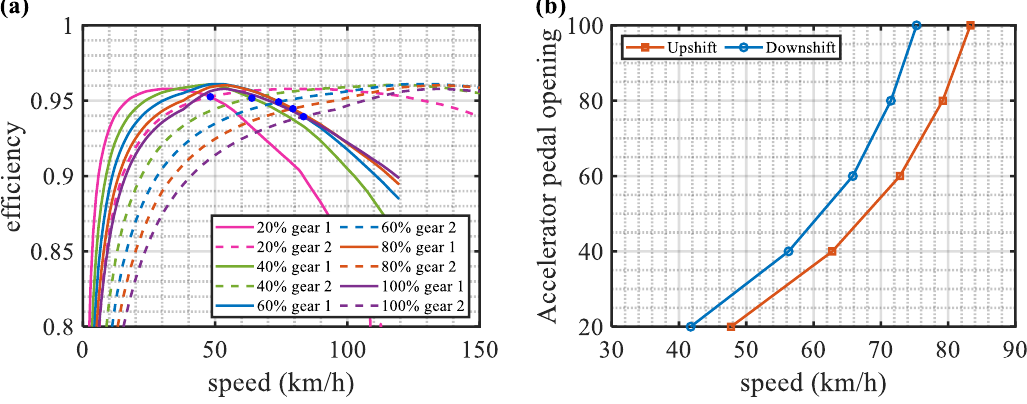
Figure 6. Economic shifting strategy: ( a ) motor efficiency curves; ( b ) economic shift curves. The economic shifting curve obtained by the above method is the upshift curve. The downshift curve is usually chosen to be another curve when the shifting speed is lower than the upshift curve. In this paper, a divergent shift rule was used to determine the economic downshift curve. This meant that the magnitude of the downshift speed delay increased with the increase of the accelerator pedal